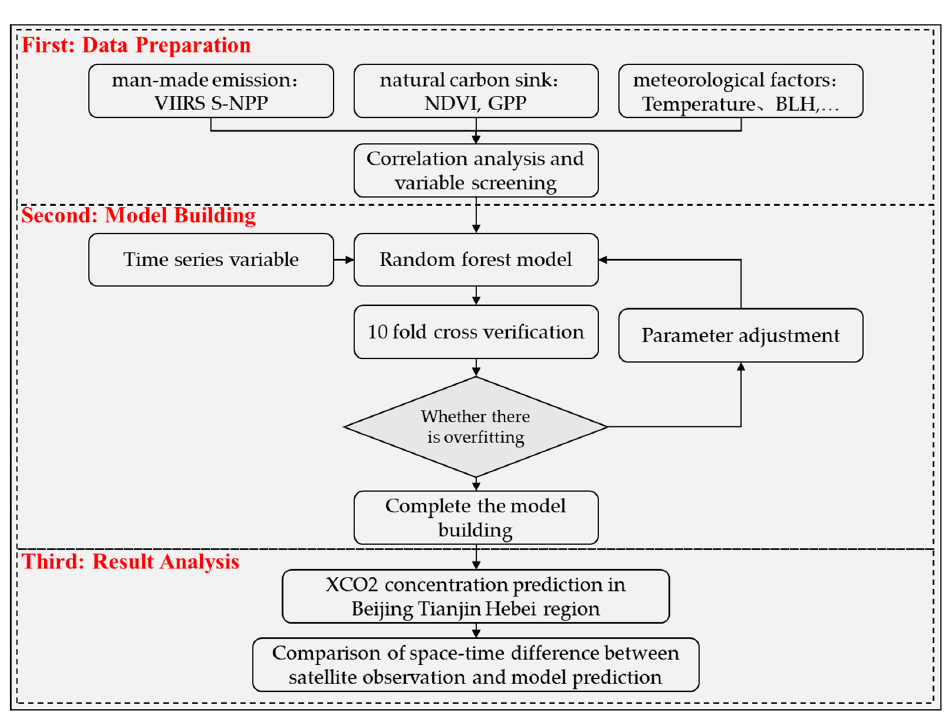
Figure 4. Flow chart of this